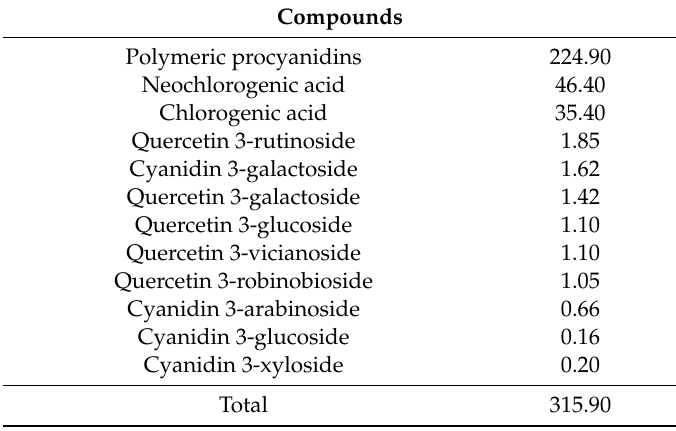
Table 4. Content of phenolic compounds in chokeberry juice (mg / 100